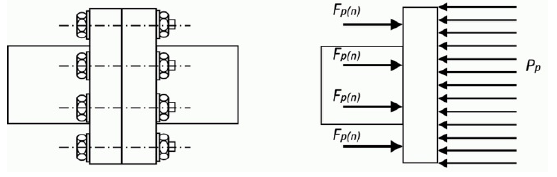
Figure 1. Preloaded Joint.